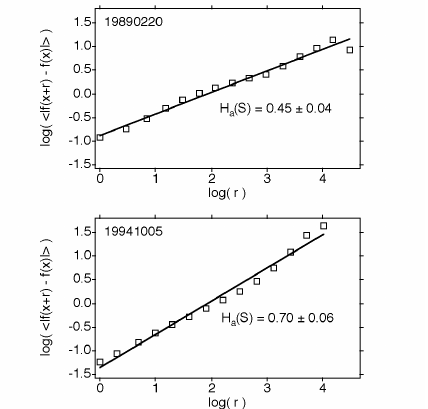
Figure 5. Upper, H for wind speed observed from the ER-2 during flight along the Arctic polar night jet stream, 19890220, the same flight as in Figure 2. It is one of the few along rather than across the jet, and has the lowest value of H recorded. Lower, the highest value of H encountered by the ER-2, cross-jet over Antarctica in October 1994. An approximate diagnostic formulation of why in meteorological terms the vertical scaling exponent of the horizontal wind speed increases with height may be found in the synoptic saying “the westerlies increase with height because it’s colder toward the pole”, expressed mathematically in the thermal wind equation [14]: